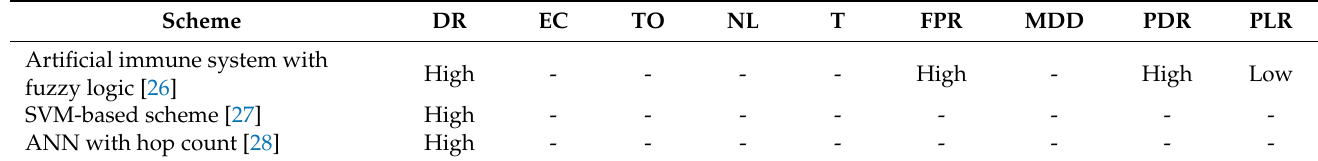
Table 6. A comparison of the performance matrices wormhole detection